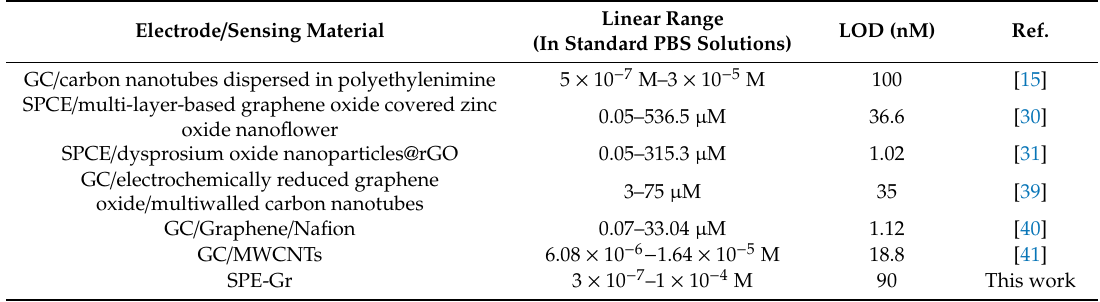
Table 2. Comparison of SPE-Gr performances with those of other types of modified electrodes.